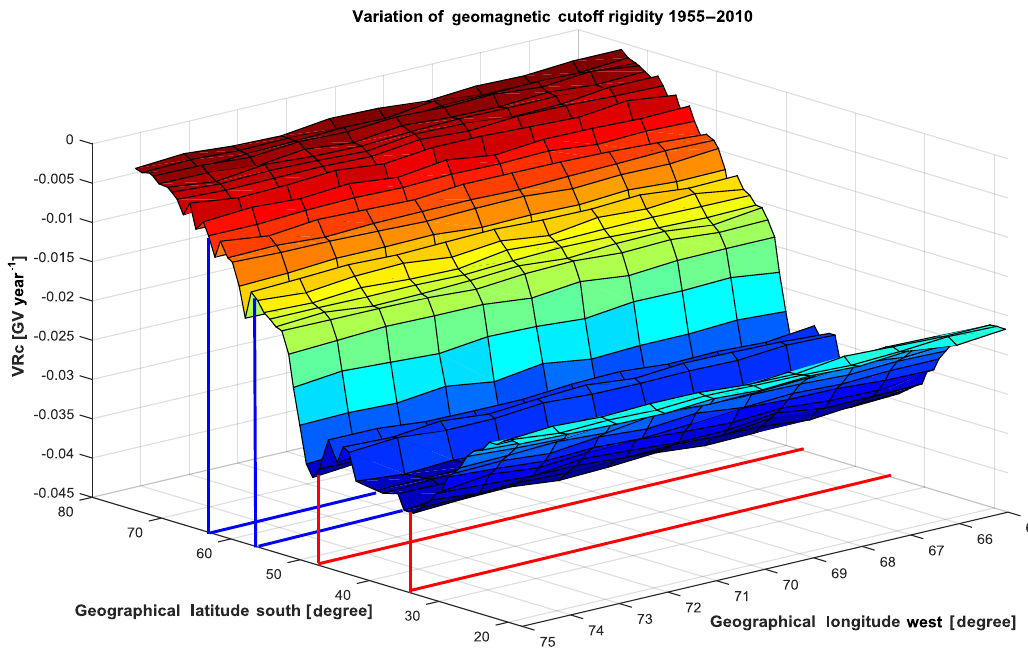
Figure 3. Values obtained for the variation rate of effective cutoff rigidity, related to special points on the Chilean coast in the geological model of Earth tectonic plates in the Southern Hemisphere. The red colors represent lower temporal changes in Rc in each location, while blue colors represent the maximum changes. The red lines indicate the latitudes of highest variation. Significant values were obtained at 46.5 ◦ S, 76 ◦ W in the Taitao peninsula in Chile, which is the triple junction point of the Nazca, Antarctic and South American plates. Furthermore, there was a high variation rate in the effective cutoff rigidity ( − 0.033) at 52 ◦ S, 76.5 ◦ W close to Puerto Natales, in the Magellan Strait in Chile, indicated by blue lines (right). The last blue line indicate the Antarctic